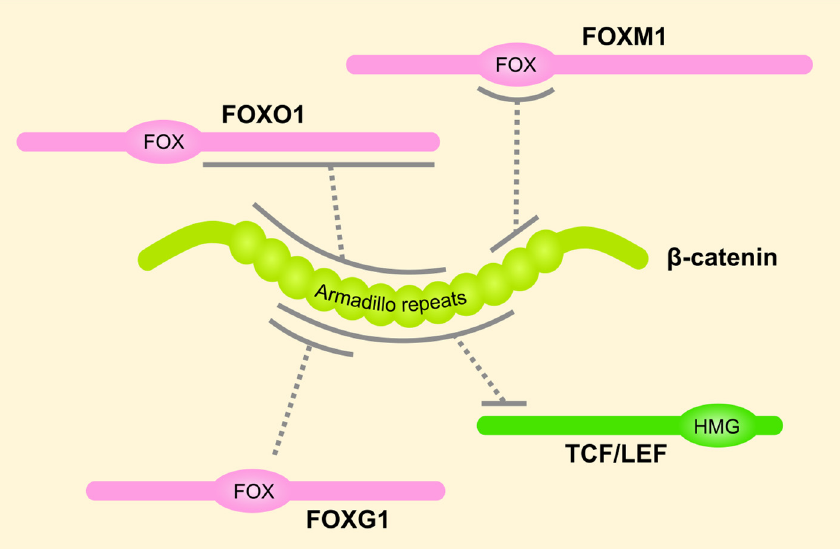
Figure 4. Schematic representation of known FOX protein/ β -catenin interactions. Solid grey lines indicate experimentally mapped binding domains. All proteins are shown in N-to-C-terminal orientation. FOX, (DNA-binding) forkhead box; HMG, (DNA-binding) high mobility group box.